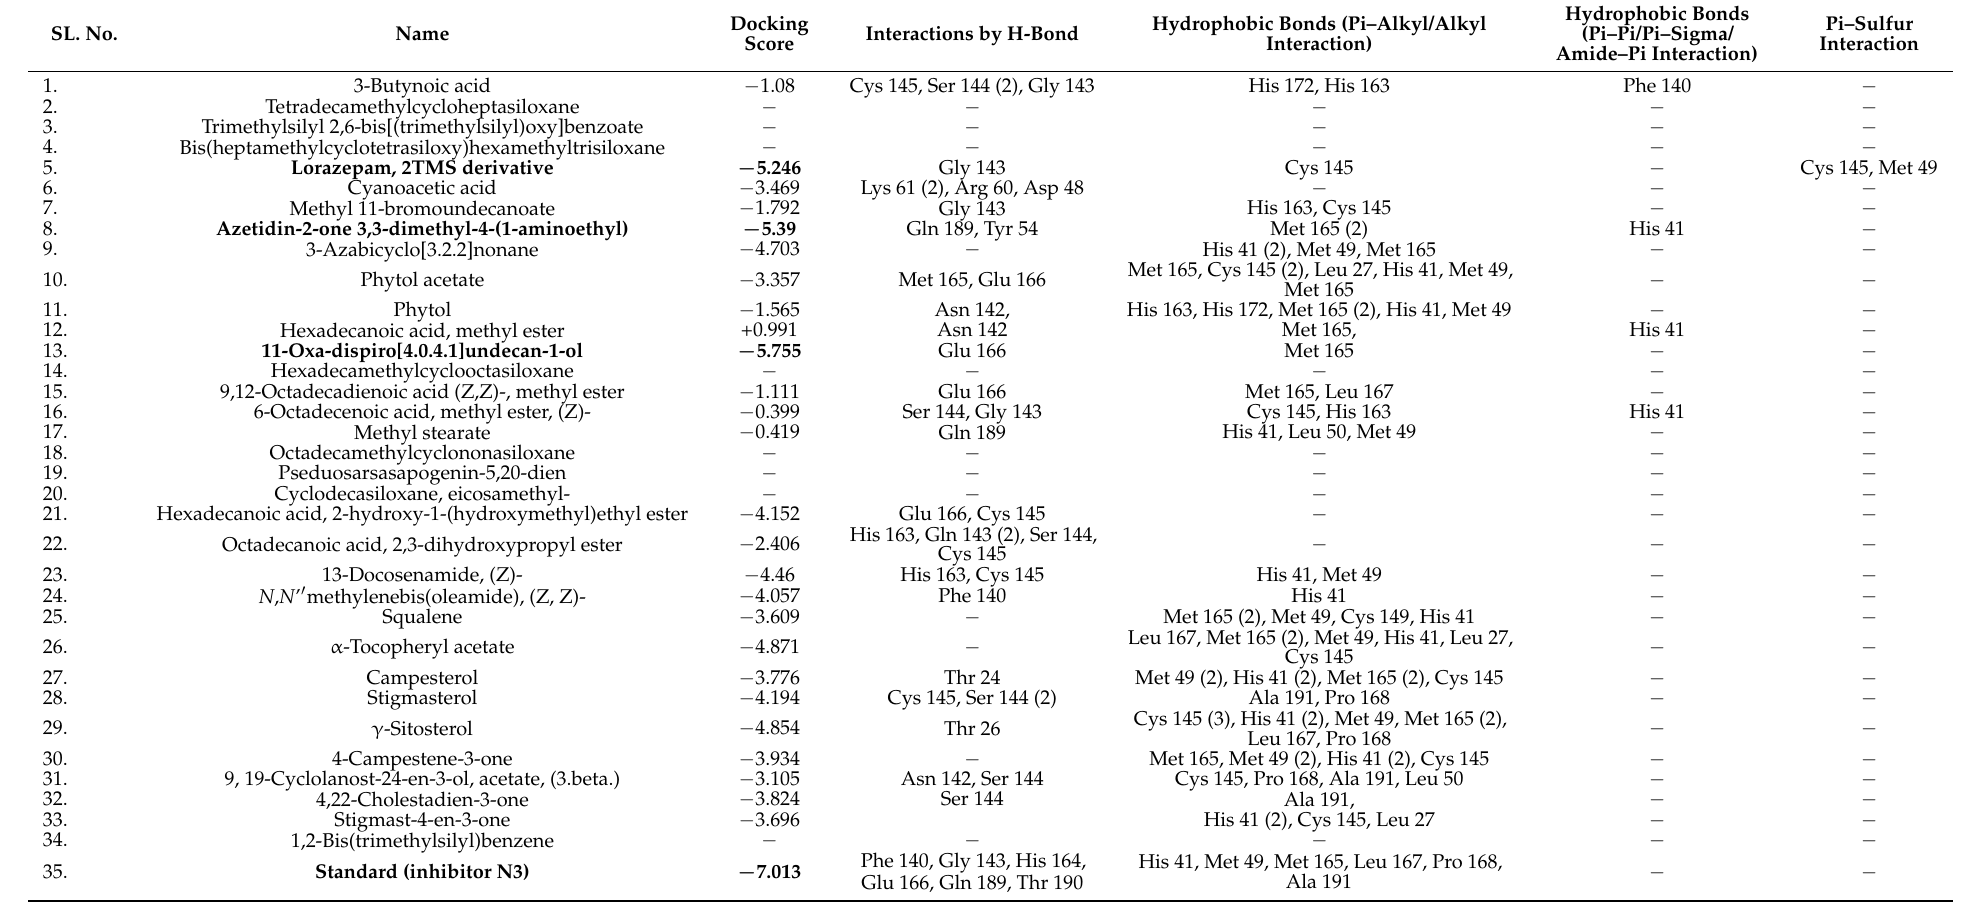
N.B.: Bold text indicates best docking